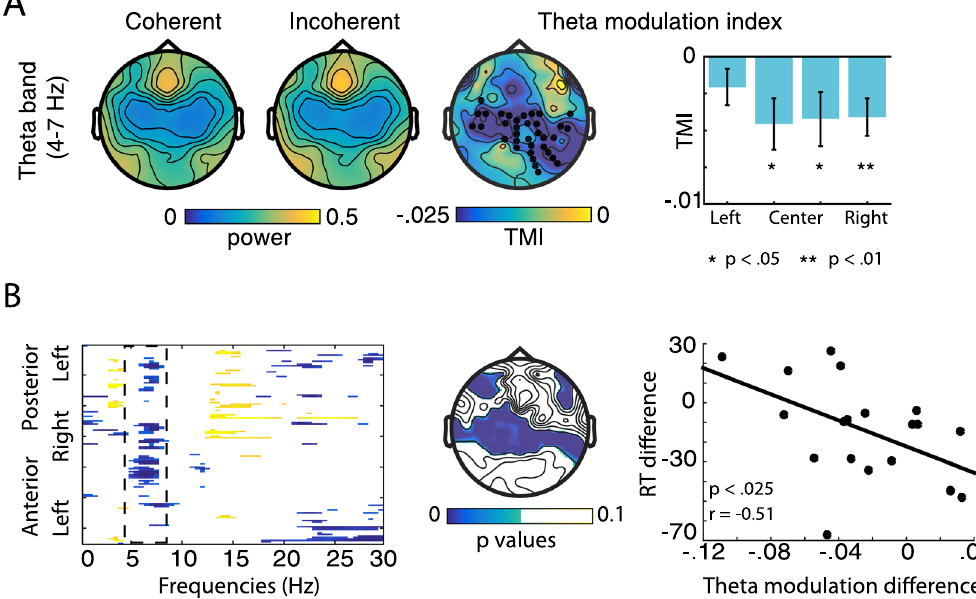
Figure 8. Theta-band results. ( A ) Results of theta-band (4–7 Hz) power analysis. Topographies are shown for the coherent (left), and incoherent condition (middle), as well as for the theta-modulation index (TMI, − theta power coherent theta power incoherent , right). Black dots indicate the channels belonging to the observed + theta power coherent ) significant cluster. The barplot shows the statistical results of testing TMI against zero, separately for the attend- left, attend-central R , attend-central L , and attend-right. ( B ) Exploratory correlation analysis between the effect of coherence between gaze and attention (coherent minus incoherent) in electroencephalographic power and response times. The left plot shows a map of the channel- and frequency wise point-by point correlation. The x-axis shows all frequencies from 1 to 30. Coded on the y-axis are all channels running from left-posterior (top) to left anterior (bottom), with each channel corresponding to one line. Only significant correlations are shown, with the correlation coefficient being coded by colour (blue = negative, yellow = positive). The middle plot illustrates the topography of all significant correlations for the theta band (4–7 Hz). For illustrative purposes, the left plot shows the correlation between the TMI and the response-times coherence effect for all significant